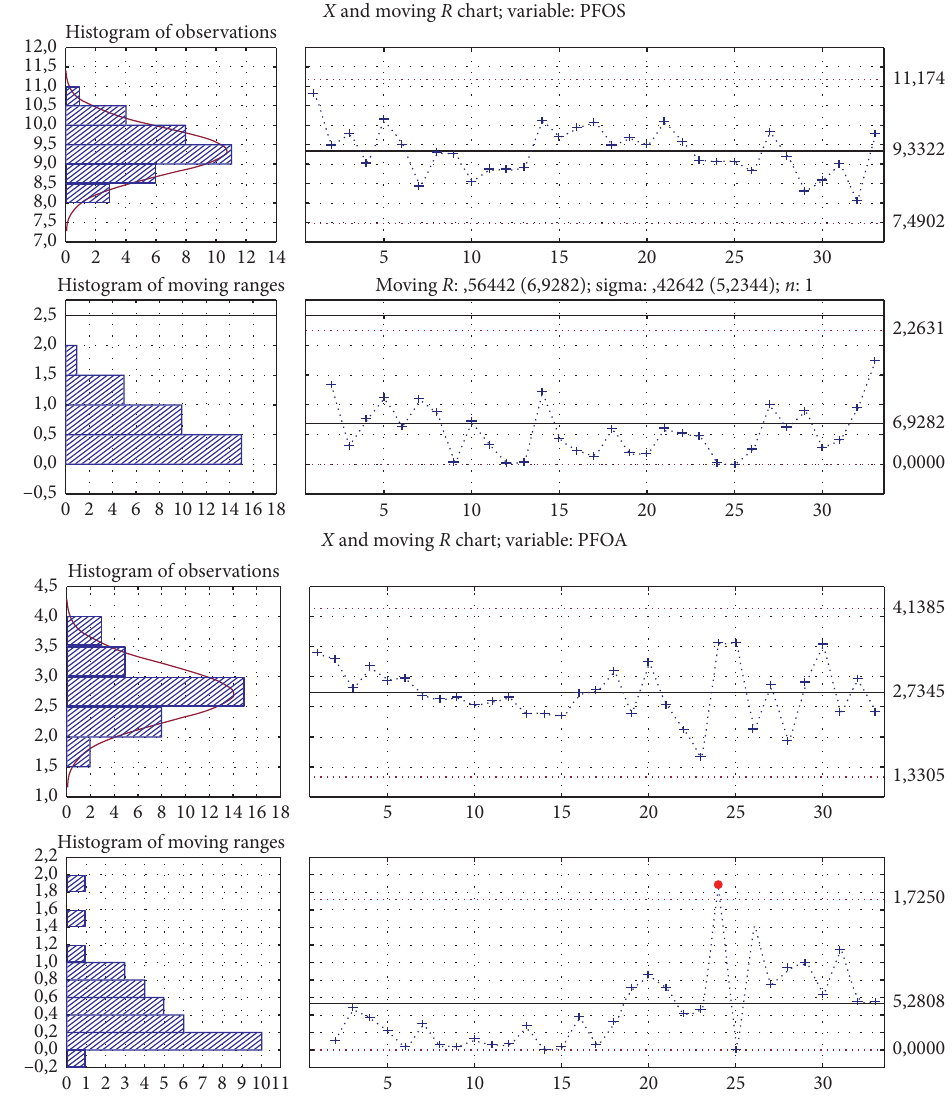
Figure 4: Quality control charts of PFOA and